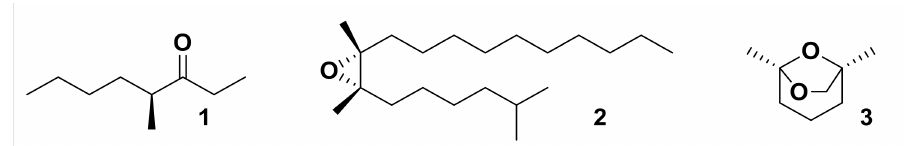
Figure 1. Early synthesized enantiomerically pure pheromones, Atta texana alarm pheromone ( S )- 4-methyl-3-heptanone 1 , Lymantria dispar sex pheromone (7 R ,8 S )-(+)-disparlure 2 and Dendroctonus brevicomis aggregation pheromone (1 S ,5 R )-frontalin 3 .